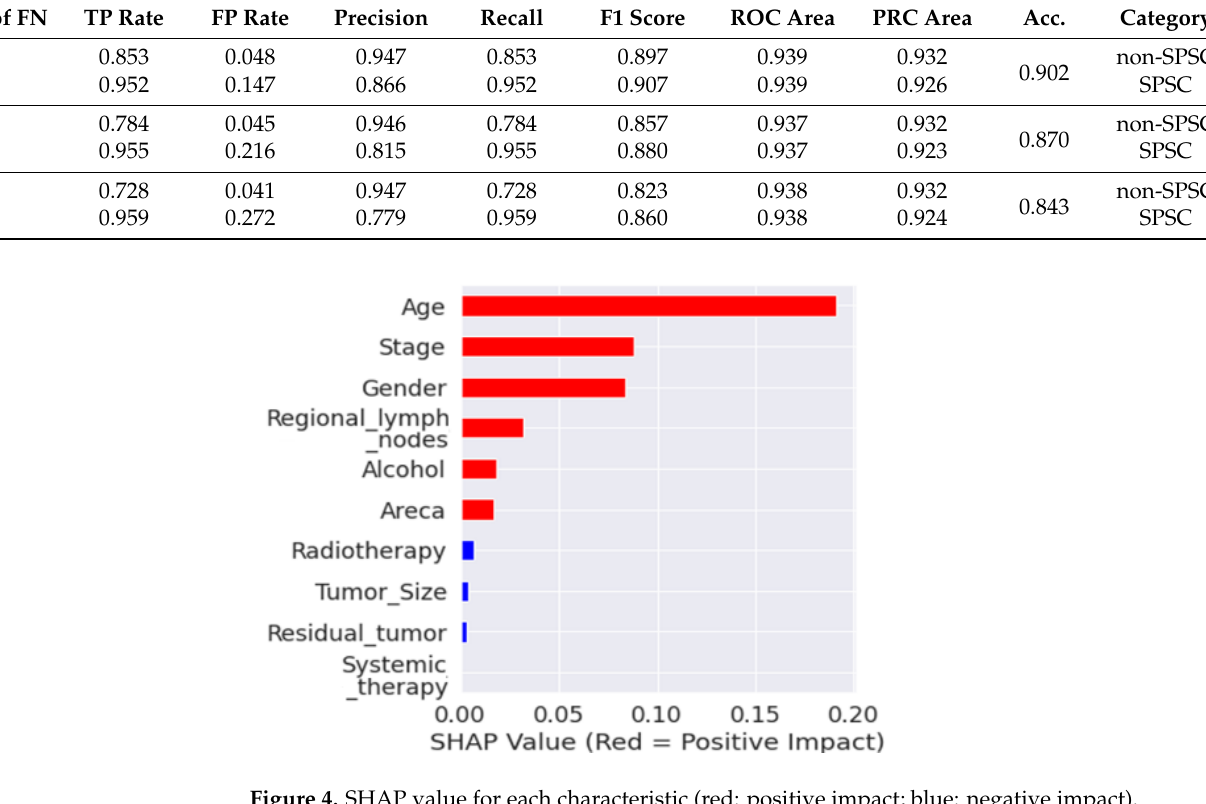
Table 3. Comparison of the random forest classification performance for different costs.